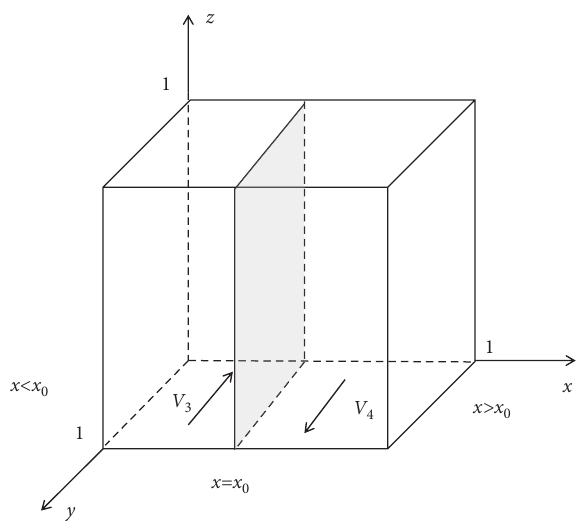
Figure 4: The dynamic trend diagram of P2P lending